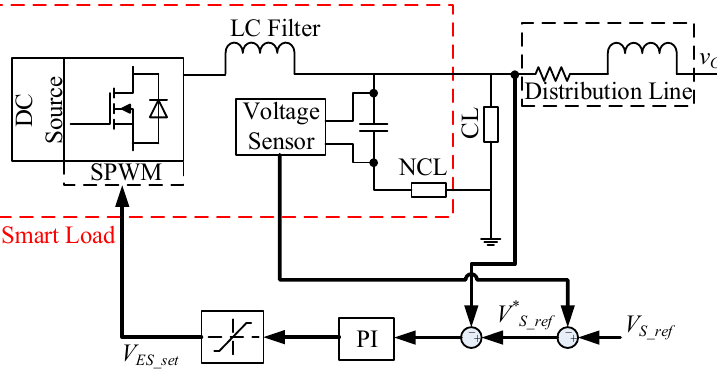
Figure 10. The droop control of ES [27].